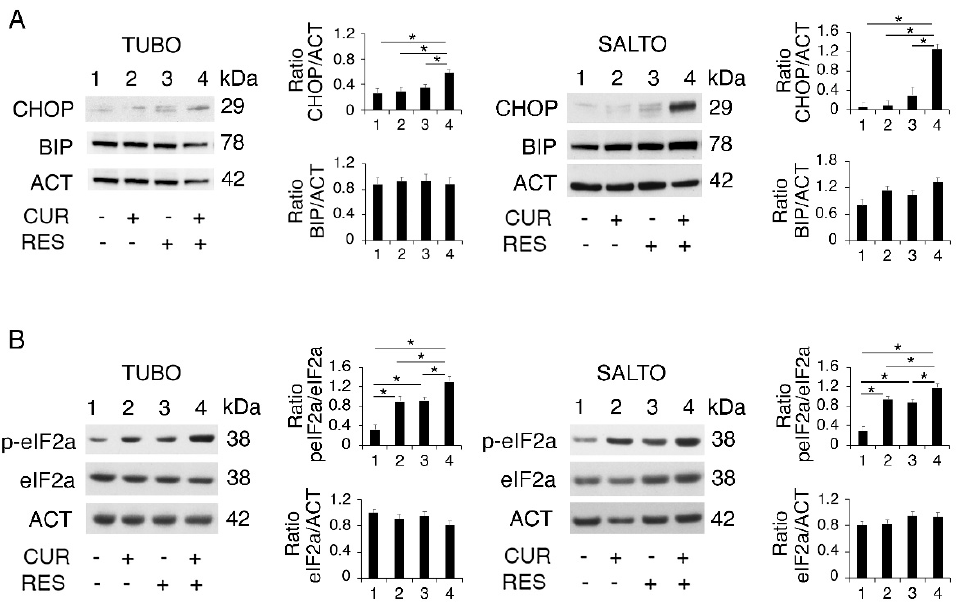
Figure 5. Curcumin and resveratrol combination activates the PERK/eIF2alpha/CHOP axis of UPR. ( A ) CHOP, BIP and ( B ) eIF2alpha activation was evaluated by Western blot in curcumin-, resveratrol- and curcumin/resveratrol-treated cells, as above reported for 48 h. One representative experiment is shown. Actin was used as a loading control. Histograms represent the mean plus standard deviation of densitometric analysis of three independent experiments. * p value < 0.05.